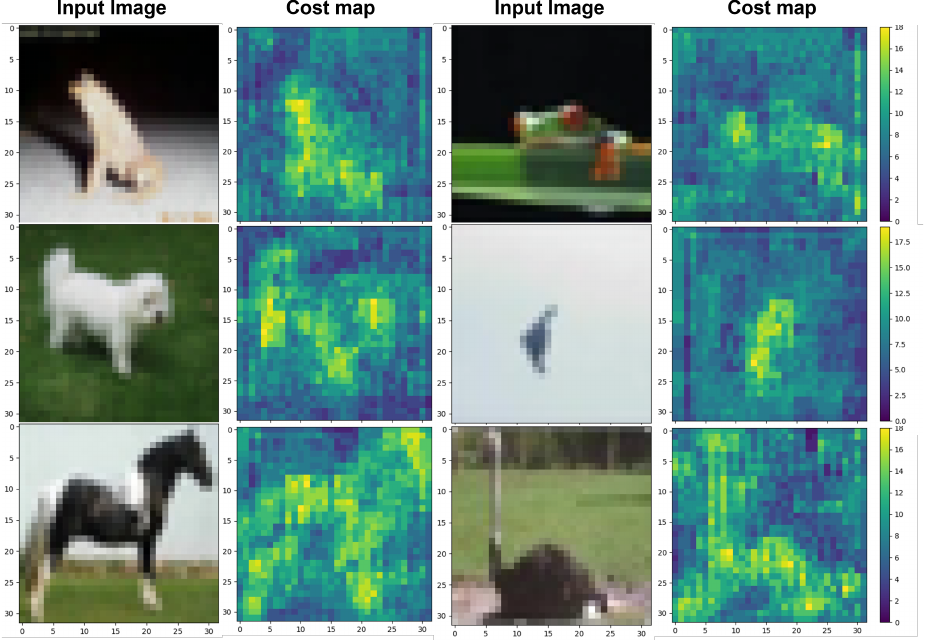
Figure 5. Ponder cost map, which represents the amount of computation at each spatial location, indicates that SG predicts spatial features on CIFAR-10